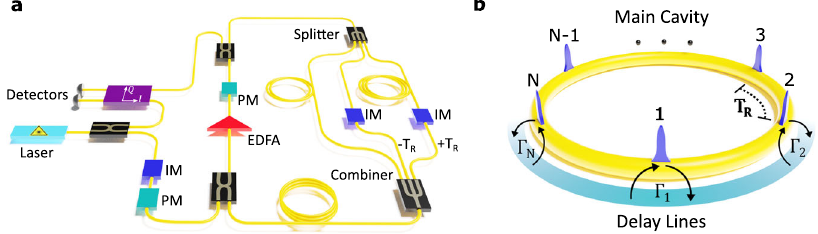
Fig. 1 | Network of time-multiplexed resonators. a Schematic diagram of the experimental setup used to implement dissipatively coupled resonators. An intensity modulator (IM) and a phase modulator (PM) are used in the input of the optical fi ber to generate arbitrary wavefunctions de fi ned by injected femtosecond pulsesfromamode-lockedlaserwitharepetitionrateof T R .AnErbium-doped fi ber ampli fi er (EDFA) is used in the main cavity to compensate for the losses and